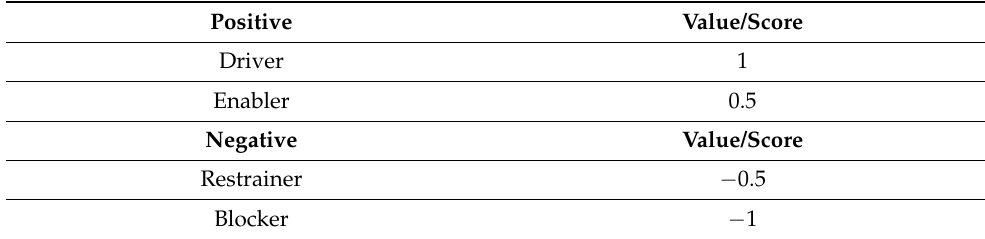
Table 4. Type of Classification Ordinal